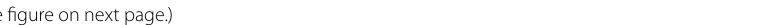
figure on next Fig. 1 Expression of XRCC2 in cancers. A The expression level of XRCC2 in cancers based on GEPIA2. B The expression level of XRCC2 in glioma cell lines based on RT-qPCR. C The expression level of XRCC2 in glioma tissues based on RT-qPCR. D Immunohistochemical staining results for XRCC2 in non-glioma and glioma tissues. Brown color represents positive XRCC2 staining. * P profiling interactive analysis 2, RT-qPCR real-time quantitative polymerase chain